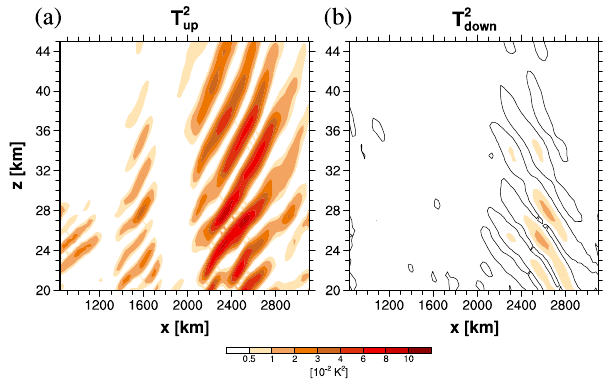
Figure 3. The same as in Fig. 2a except for variances from decomposed components of (a) upward and (b) downward waves. In (b), regions of 10 − 3 K 2 are plotted with black contours.